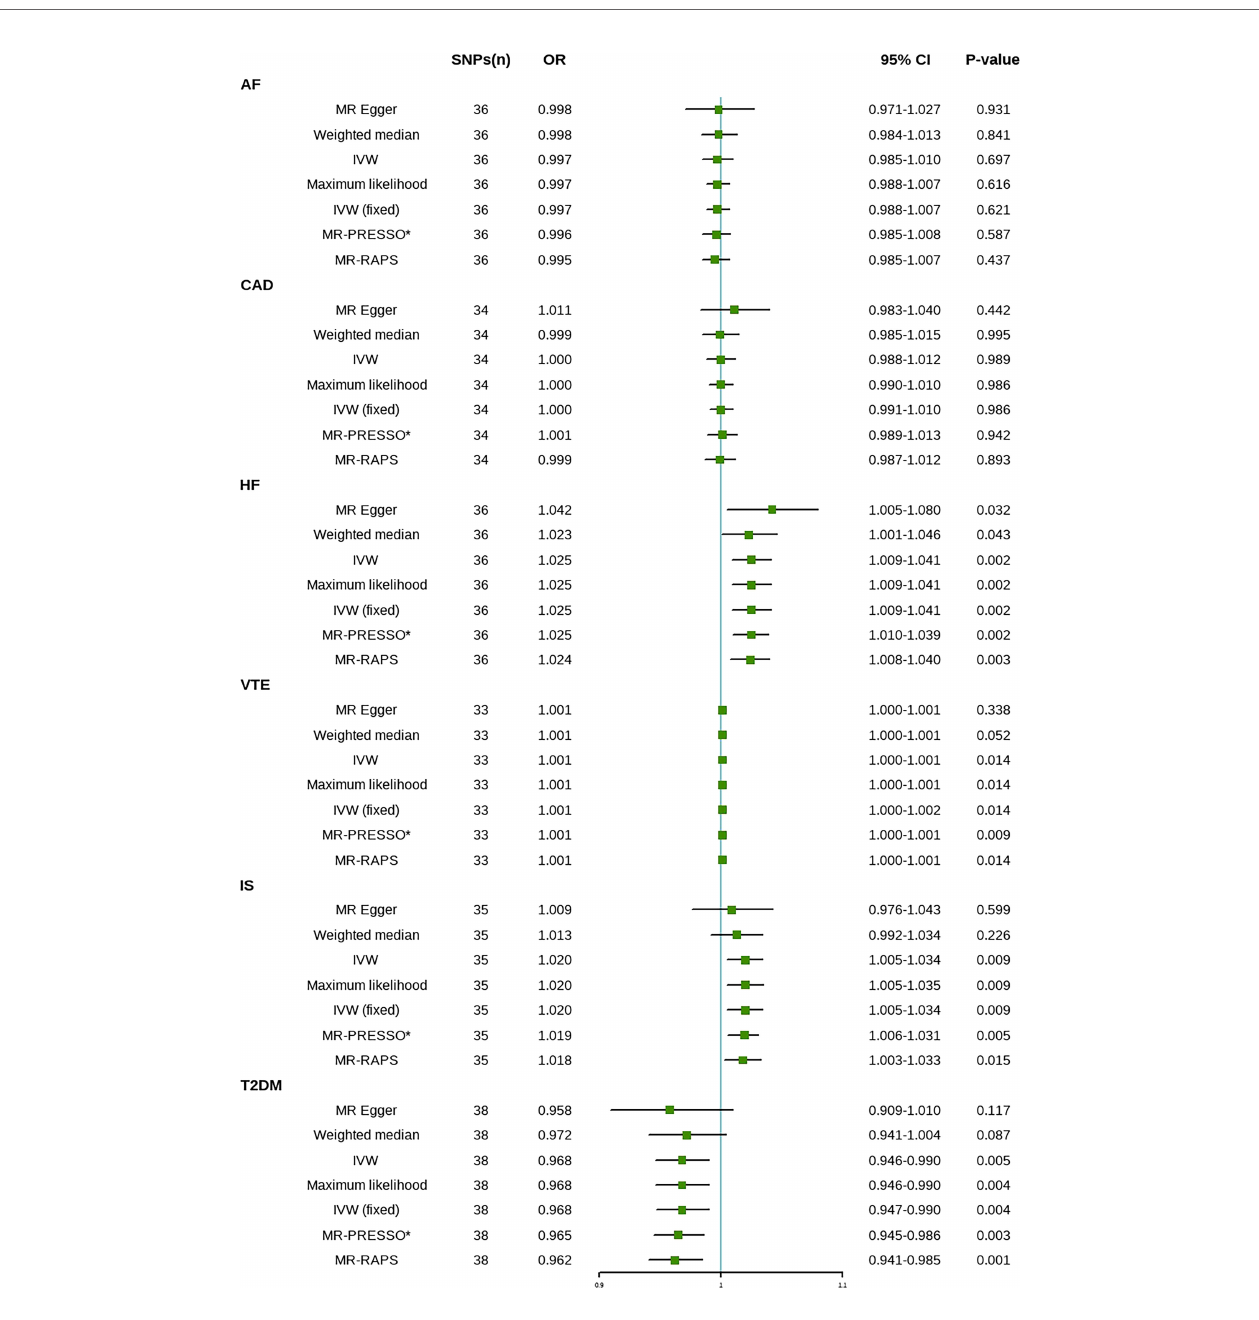
FIGURE 2 | Mendelian randomization estimates of SLE on the risk for CVD. SNPs, Single nucleotide polymorphisms; OR, Odds ratio; CI, Con fi dence interval; IVW, inverse-variance weighted; IVW ( fi xed), fi xed-effects inverse-variance weighted; MR-RAPS, MR-robust adjusted pro fi le score; MR-PRESSO, MR-pleiotropy residual sum and outlier; *No outlier was detected; AF, atrial fi brillation; CAD, coronary artery disease; HF, heart failure; IS, ischemic stroke; T2DM, type 2 diabetes. VTE, Venous ( Supplementary Figure 1 ). The results of the maximum likelihood, MR-PRESSO, and MR-RAPS analyses were consistent with the IVW method. No outliers were identi fi ed using the MR- PRESSO method, indicating that the results are reliable. The risk calculation was based on the log OR of SLE, which may partly explain the low ORs.